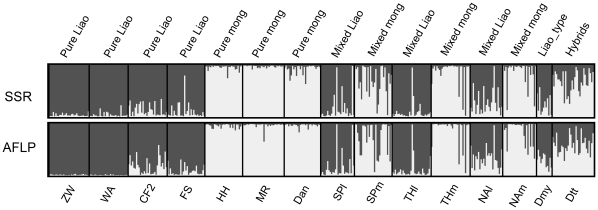
STRUCTURE results for two clusters with no prior population knowledge.Results are based on 19 SSR loci (above) or 194 AFLP markers (below). Each individual is represented by a thin vertical line. Black lines separate individuals of different populations. Populations are labelled below the figure with their regional affiliations. Previous population morphological information is provided above the figure. (Pure Liao: pure Quercus liaotungensis; Pure Mong: pure Q. mongolica; Mixed Liao and Mixed Mong: Q. liaotungensis and Q. mongolica from mixed forests, respectively.